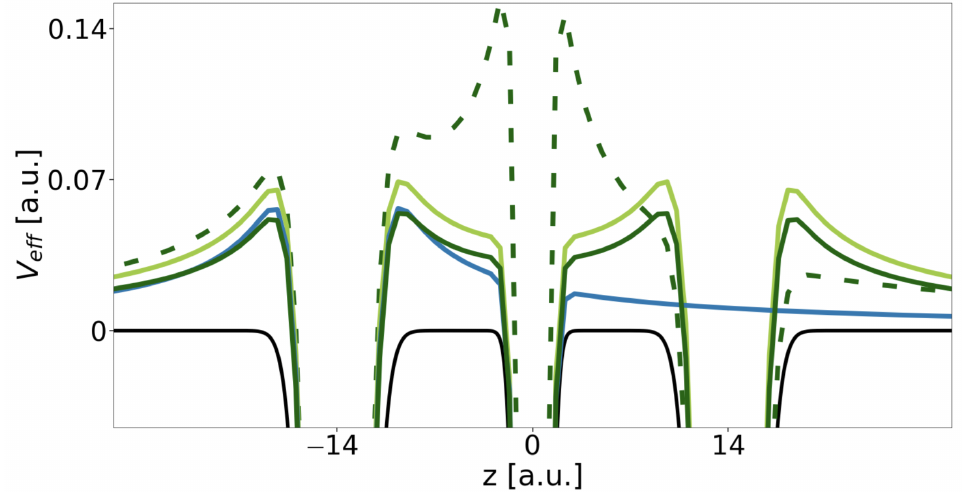
Figure 4. Illustration of the three-QD array ABA potential (black) displayed for R AA = 28a.u. within [ − 0.045,0.152 ] a.u. Furthermore, the effective Coulomb barriers resulting from electron configurations with the electron from B in the continuum, i.e., A ∗ B + A (dark green), AB + A (light green) and AB + (blue), respectively, as well as effective Coulomb barriers resulting from excited ICD electron configurations, i.e., ABA + (dashed dark green), are